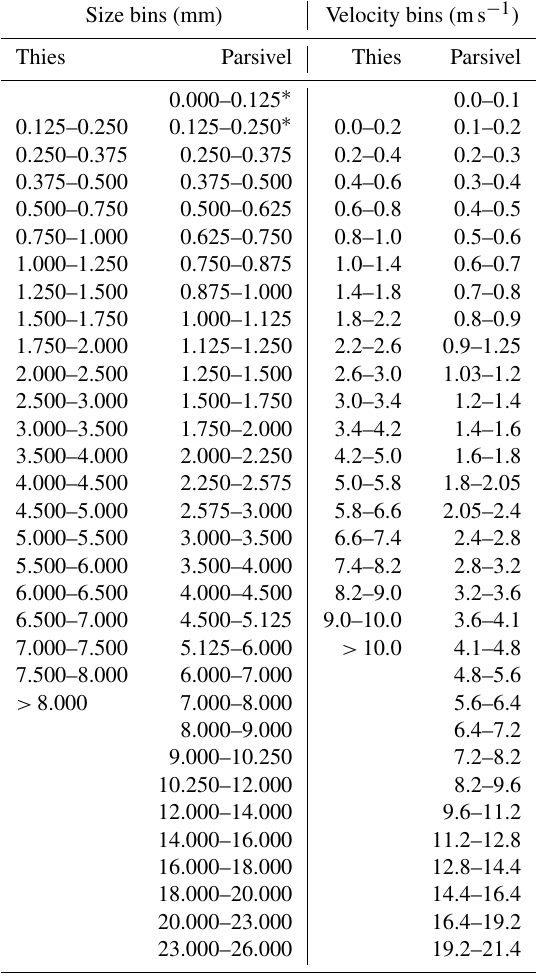
Table 1. Classification or particles according to equi-volume diam- eter ( D ) and fall velocity ( V ) bins by disdrometer